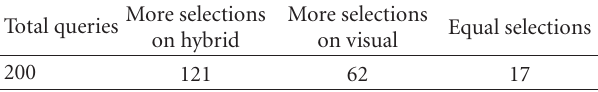
Table 4: Pairwise comparison of the hybrid retrieval function with the visual one.